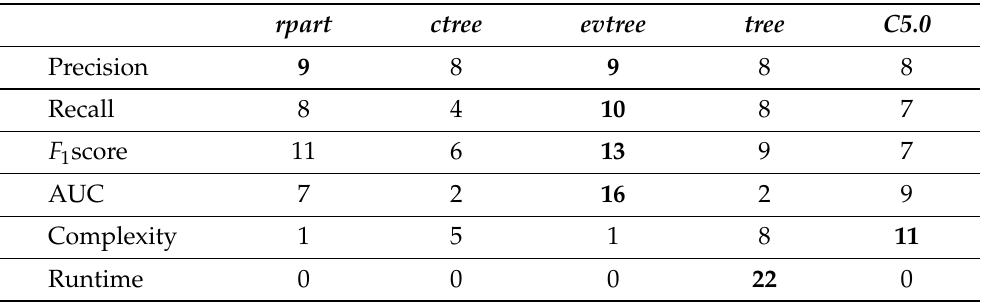
Table 4. In this summary table, rpart and evtree scored highest in 9 data sets with regard to Precision. evtree scored highest in 10, 13 and 16 data sets with regard to Recall, F 1 score and AUC, respectively. C5.0 scored highest in 11 data sets with regard to creating complex trees. Finally, tree shows that it is the fastest. The highest scores in each category are highlighted in bold font.